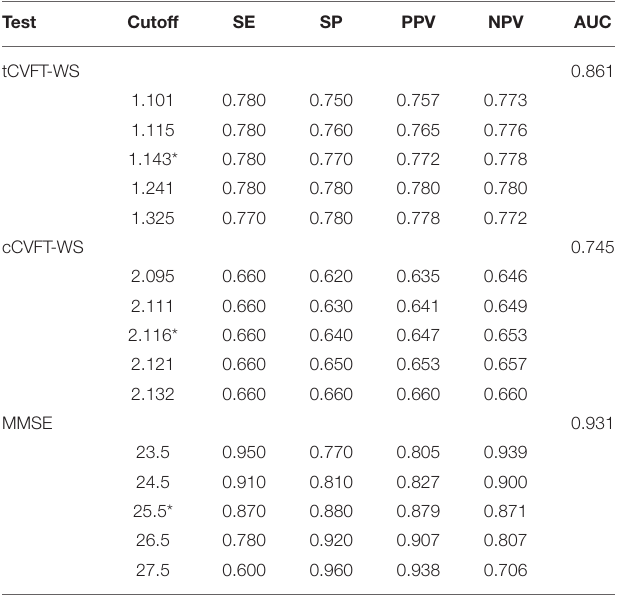
TABLE 4 | Diagnostic accuracies, regarding early Alzheimer’s disease, of the semi-automatically administered categorical verbal fluency test, conventionally administered categorical verbal fluency test, and Mini-Mental State